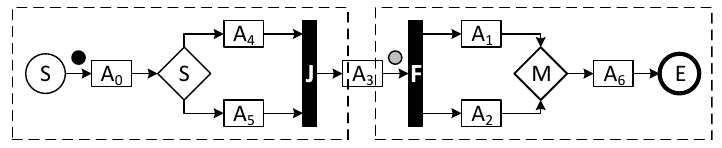
Figure 7. A workflow graph whose execution is blocked in the join node